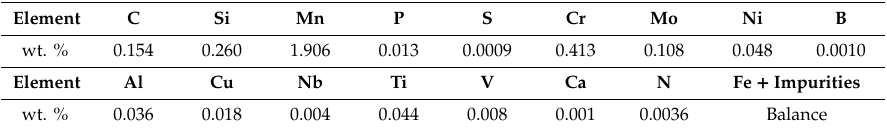
Table 1. Chemical composition of the experimental steel.